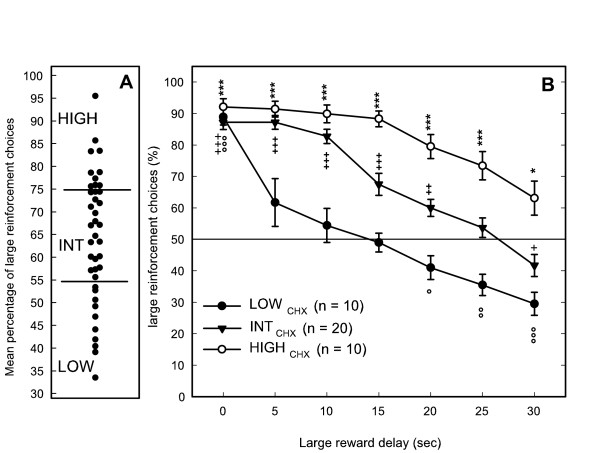
Inter-individual differences in impulsivity measured in the delay-discounting task: A: distribution of individual scores of each rat (mean percentage of choice for the large reward after 5 to 30 min delays) and selection of rats with high choice for large reward (HIGHCHX, scores > 75%) low choice for large reward (LOWCHX, scores < 55%) and intermediate rats (INTCHX). B: Percentage choice of the large reinforcement of the three groups according to the length of the delay before obtaining it: LOWCHX had no preference for any lever at delays 5 to 15 min and then shifted their preference for the immediate reward, whereas HIGHCHX preferred the largest reward whatever the delay. Comparisons with chance level (50%): significant difference with chance for scores above or below 50% show a preference for the large or the small reward respectively. Student t-test: ***, +++, °°°, p < .001; **, ++, °°, p < .01; *, +, °, p < .05.